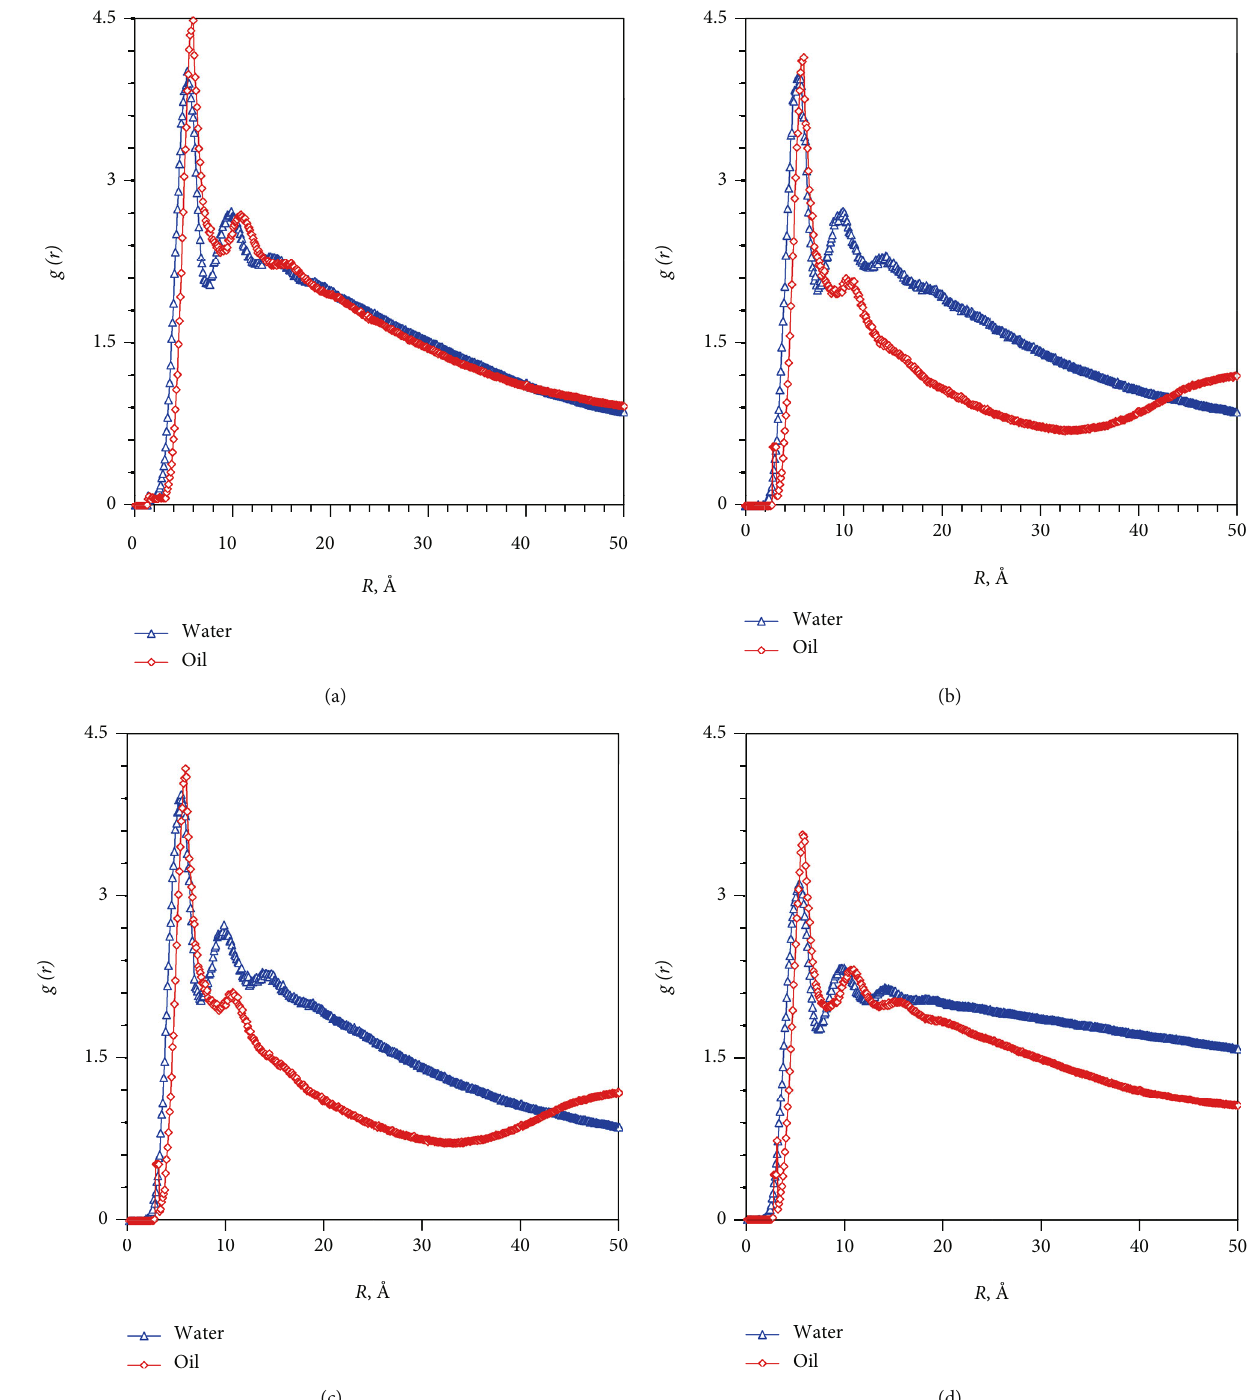
Figure 9: Radial distribution function curves: (a – c) models 1 – 3; (d) model